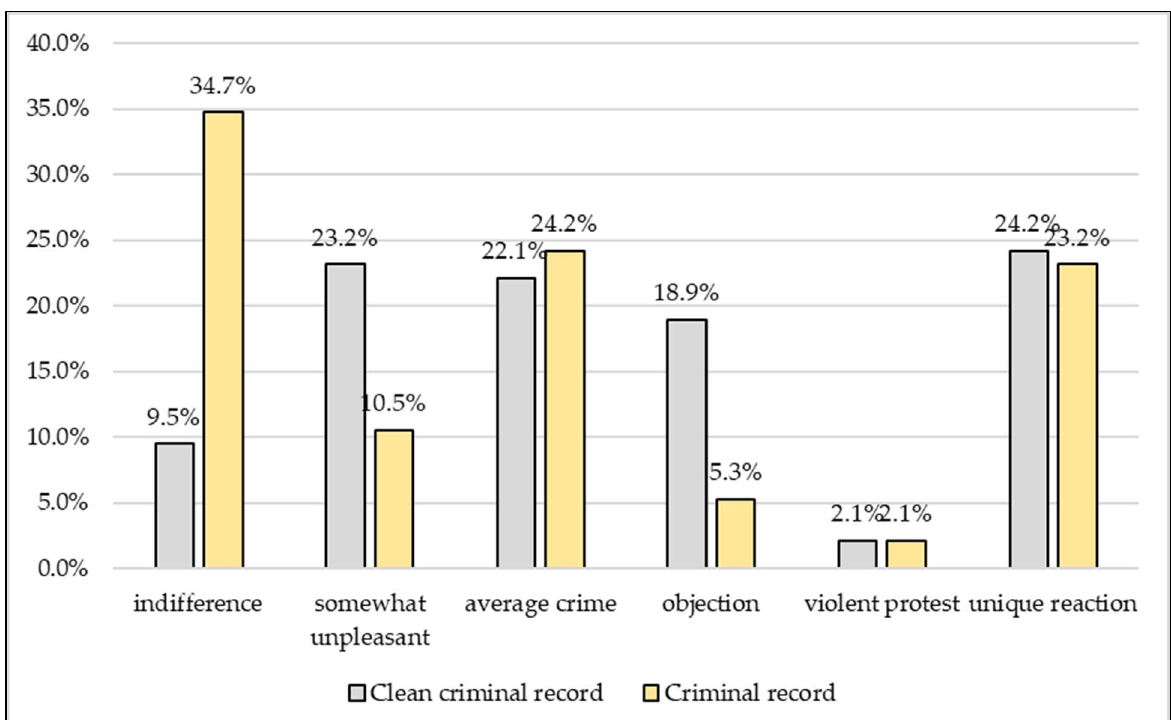
Figure 6. What effect does the suspicion of animal cruelty have on the suspects, depending on whether they have a criminal record or not? ( n = 99).